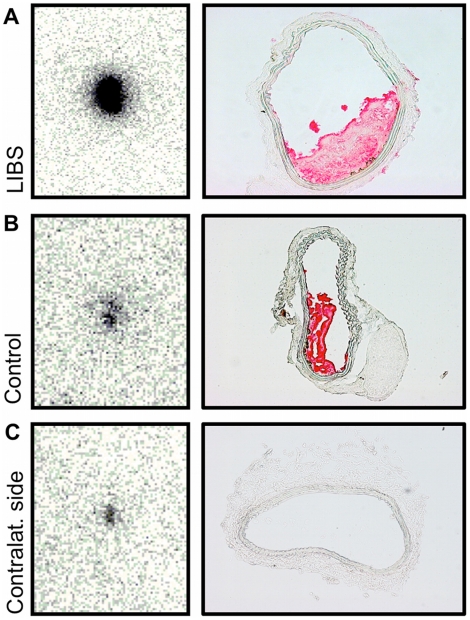
Ex vivo autoradiography of carotid artery
thrombosis.
Ex vivo autoradiography of carotid artery specimens
(left column) and appendent transversal histology sections of carotid
arteries immunohistochemically stained for CD41 (right column).
Autoradiography of the injured carotid artery, after treatment with
ferric chloride, reveals a strong ligand uptake after incubation with
111In-LIBS (A). Corresponding histology proves the
presence of a non-occlusive wall-adherent thrombosis. After incubation
with 111In-control, the radioligand uptake appears visually
decreased (B). Autoradiography of the carotid artery on the
contralateral non-injured side allowed the assessment of background
radiation in the absence of an intravascular thrombosis (C).